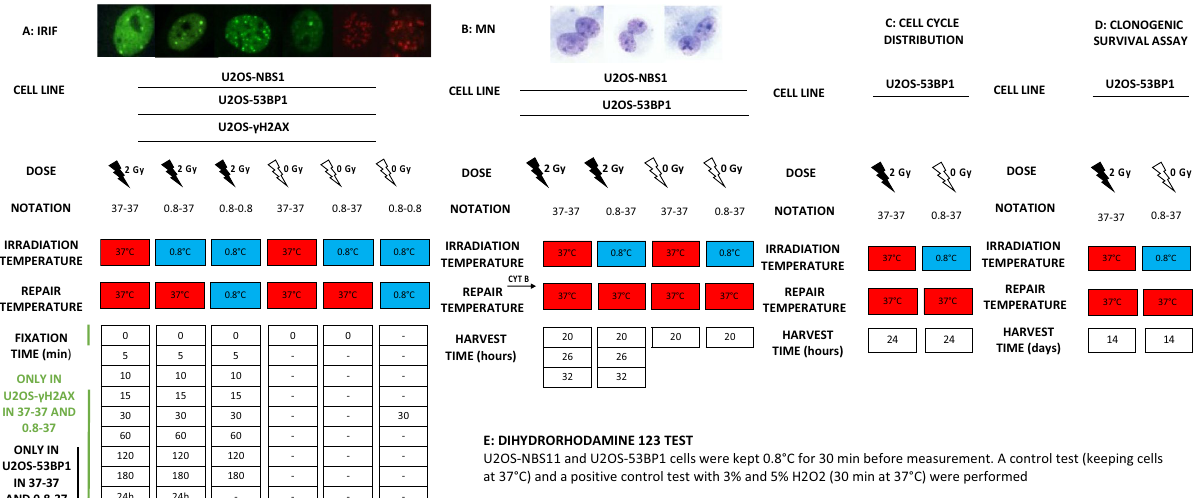
Level of reactive oxygen species. Oxidative stress induced by hypothermia was quantified in U2OS- NBS1 and U2OS-53BP1 cells with the help of the dihydrorhodamine 123 test. To this end U2OS cells were kept on melting ice (0.8 °C) for 30 min. After treatment with hypothermia cells were harvested and dihydrorhoda- mine 123 (DHR, final concentration, 5 μM; Thermo-Fisher, D23806) was added as described by the producer. Cells were incubated with DHR for 30 min, washed with PBS and the level of fluorescence at 528 nm was